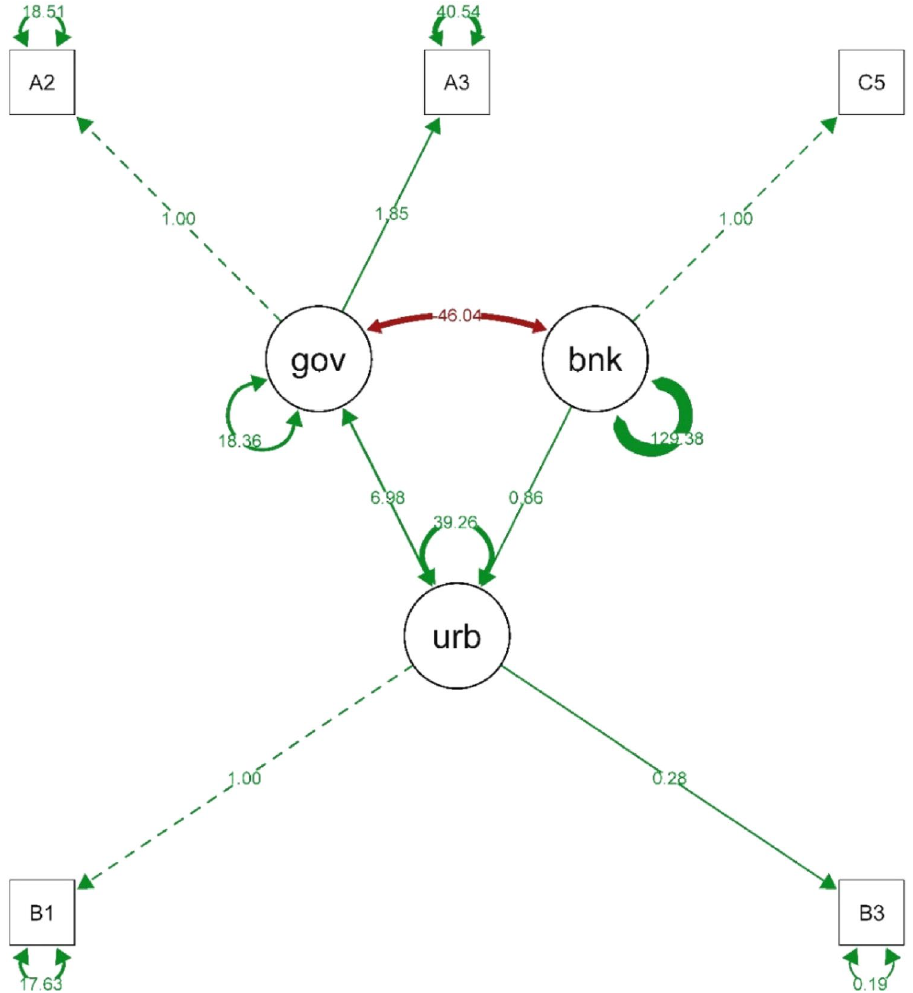
Fig. 8 Diagram of the devel- oped structural equation